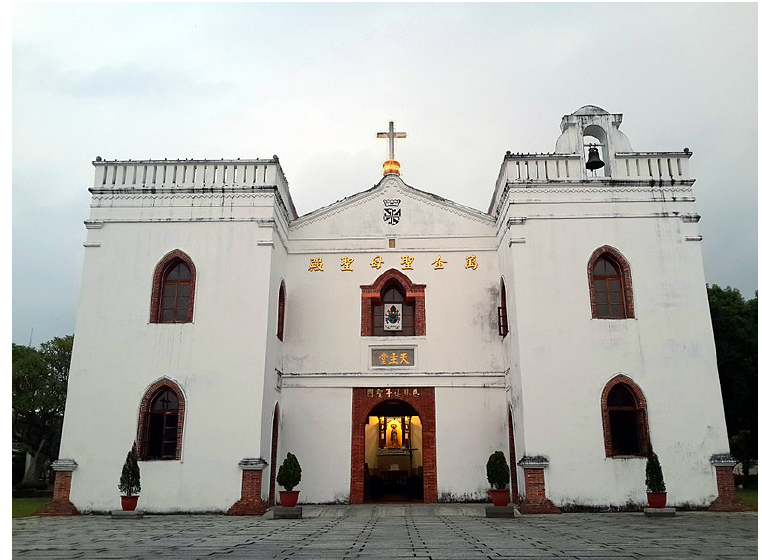
Figure 6. Wanchin Basilica of the Immaculate Conception 萬 金 聖 母 聖 殿 , is a Basilica church in Wanjin Village, Wanluan Township, Pingtung County, Taiwan.